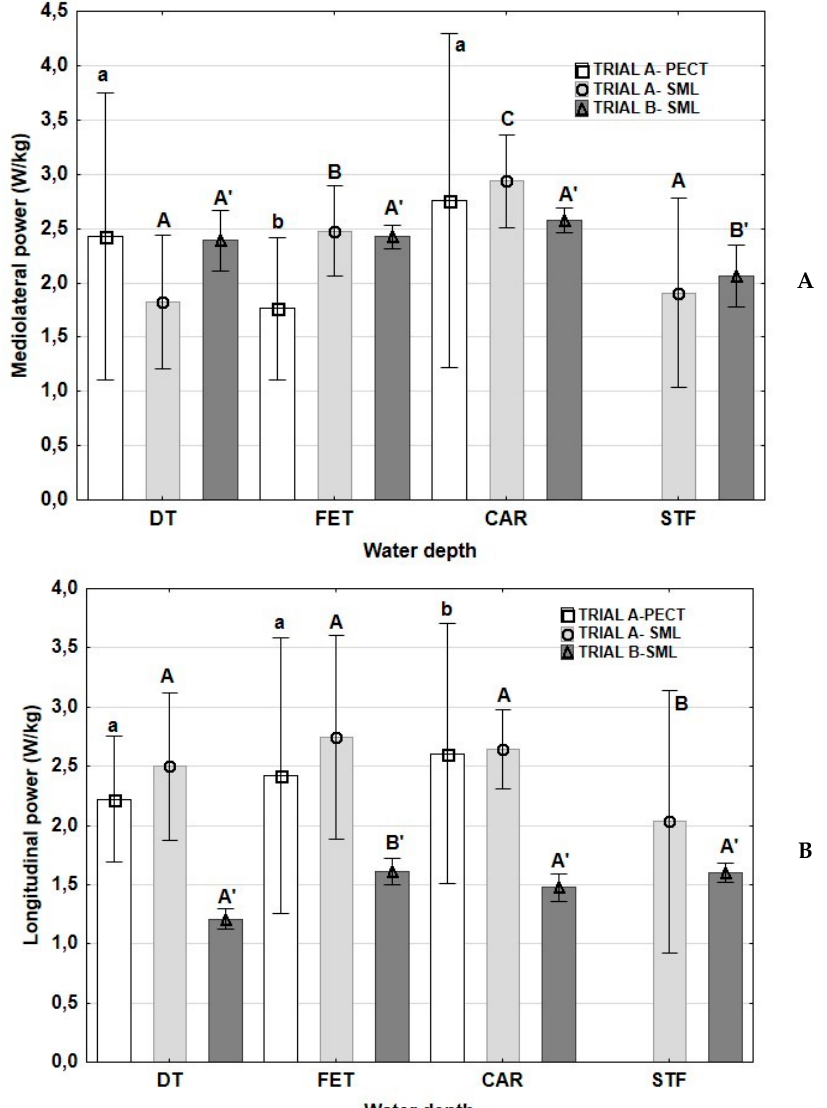
Figure 3. Means and standard deviations (whiskers) of longitudinal ( A ) and mediolateral ( B ) power in horses exercised on a water treadmill at different water depths and velocities. DT: dry treadmill, without water; FET: water at the level of the fetlock; CAR: water at the level of the CAR; STF: water at the level of the stifle. Trial A-PECT: accelerometer fixed in the pectoral region with velocities of 6 km/h; Trial A-SML: accelerometer fixed in the sacrum midline at velocities of 6 km/h with the water at DT, FET and CAR and at a velocity of 5 km/h with the water at STF; Trial B-SML: accelerometer fixed in the sacrum midline at a velocity of 5 km/h in the four water depths. Lowercase letters: significant differences between water depths in trial A-PECT; capital letters: significant differences between water depths in trial A-SML; capital letters with apostrophes: significant differences between water depths in trial B-SML. Different letters indicate significant differences between water depths at each trial p < 0.05.